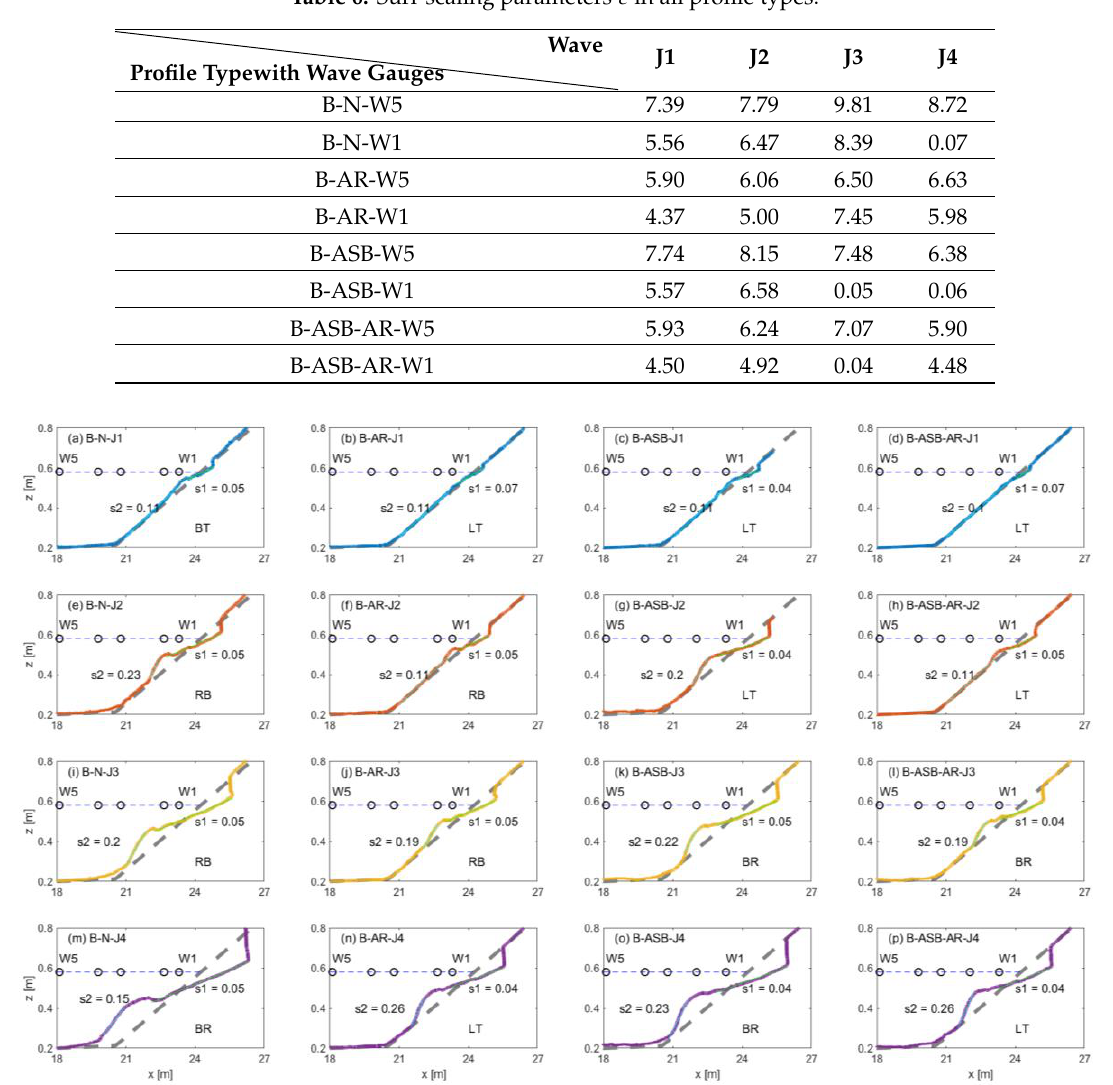
Table 6. Surf-scaling parameters ε in all profile types.